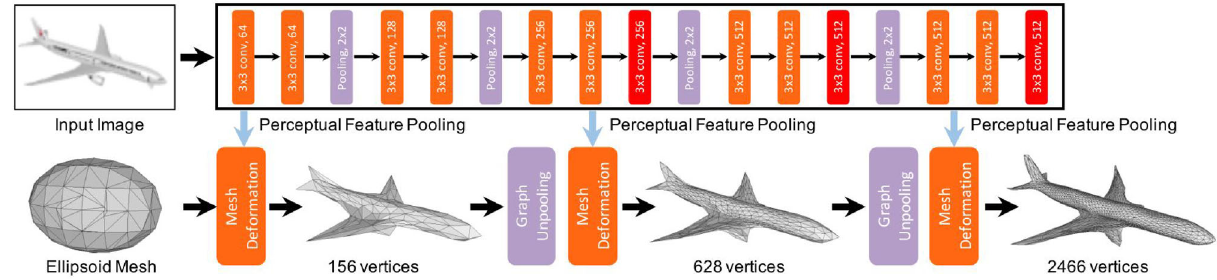
Fig. 3 Pipeline of Pixel2Mesh . Reproduced with permission from Ref. [23], c (cid:2) Springer Nature Switzerland AG